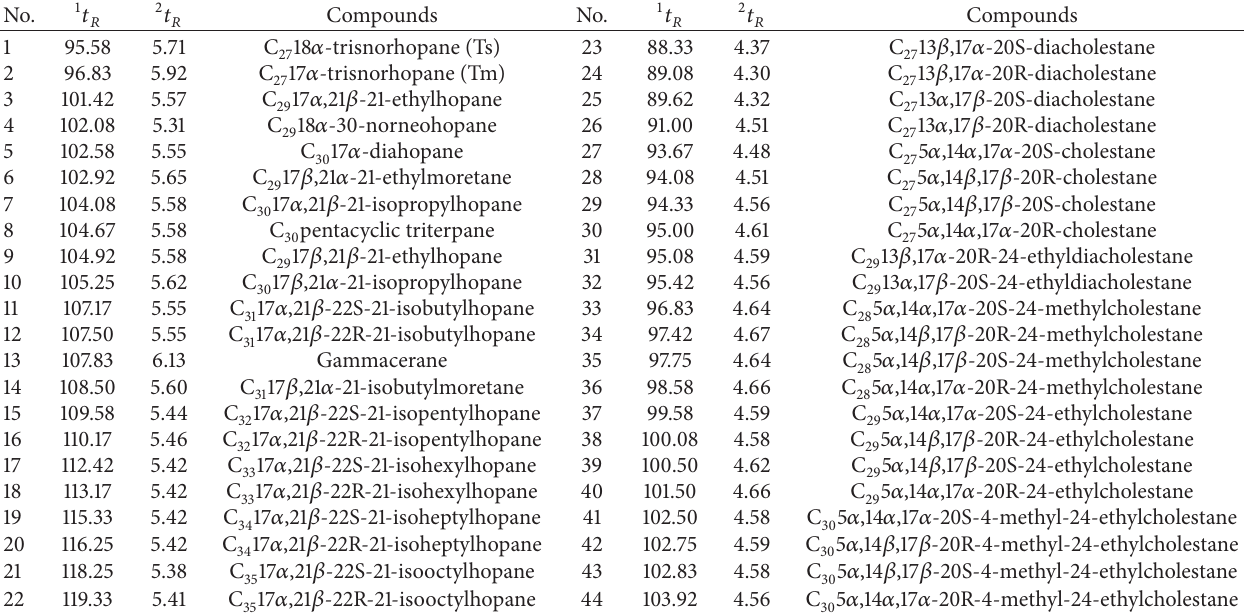
Table 3: Identification of polycyclic terpanes and steranes marked in Figure